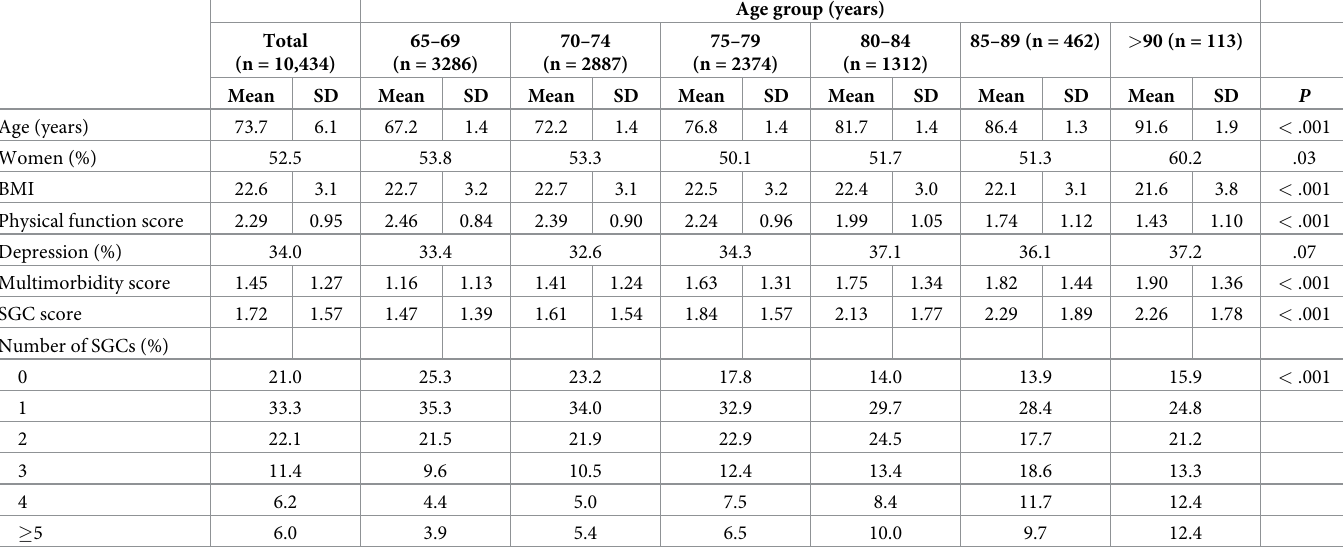
Table 1. Characteristics of the study